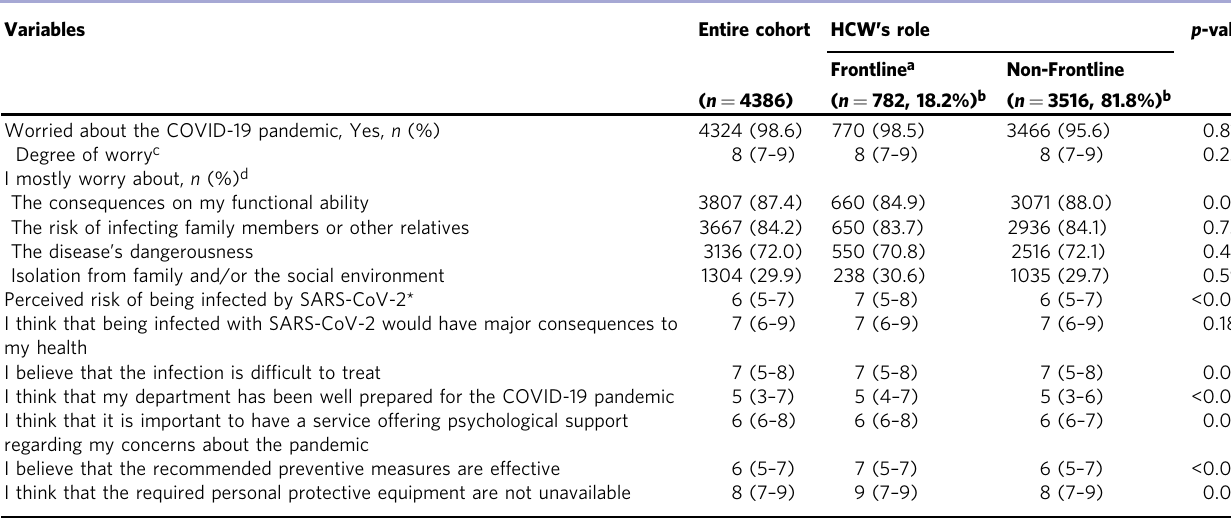
Table 2 Healthcare workers ’ worries and concerns about the COVID-19 pandemic.